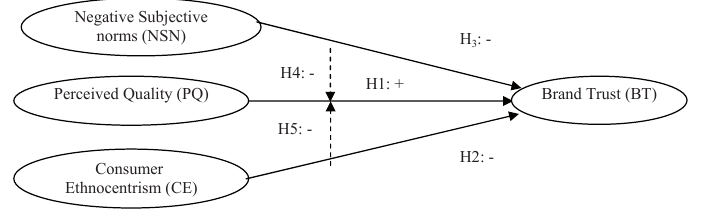
Fig. 1 - Conceptual Model. Source: